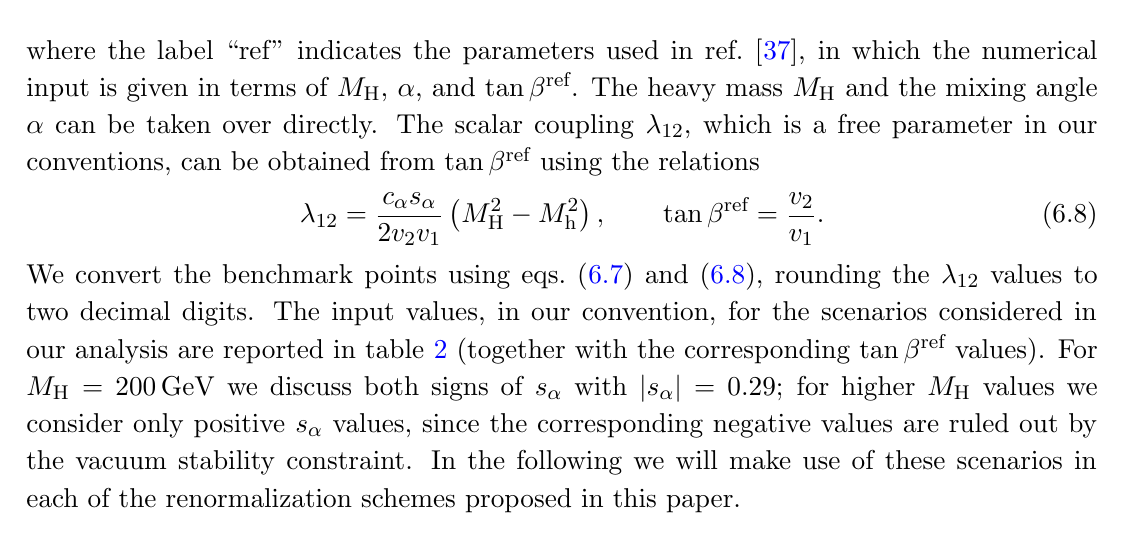
Table 2 . Input values for the SESM for a selection of benchmark scenarios for the SESM proposed in refs. [3, 37], converted to the notation used in this work. In brackets, the tan (cid:12) ref values used in eq. (6.8) to compute the corresponding (cid:21) 12 values are